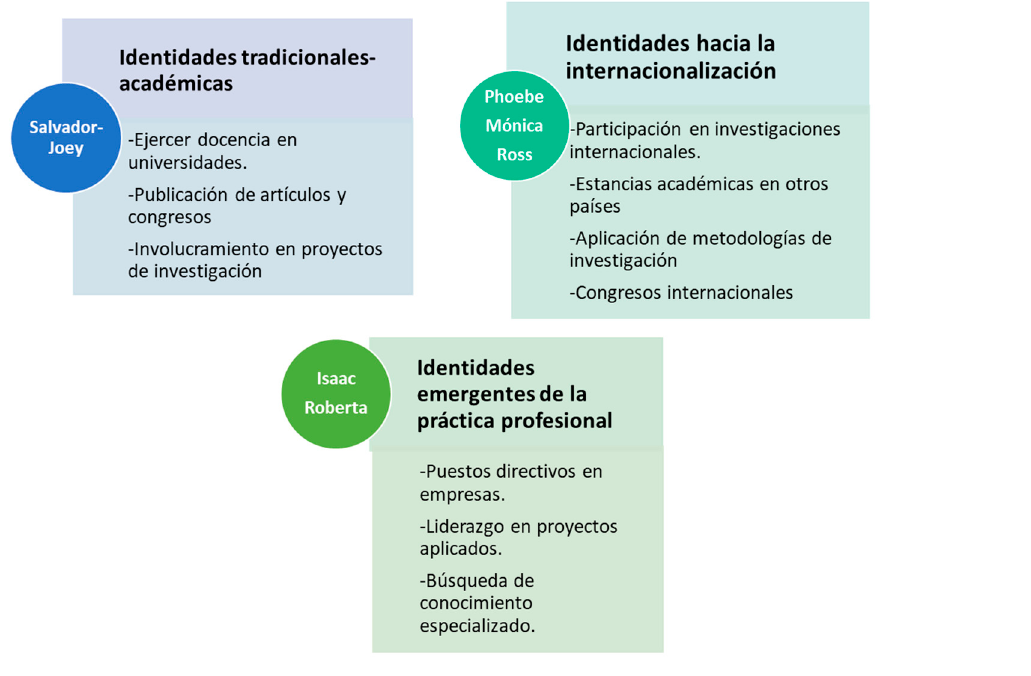
Figure 1. Grouping of the identities displayed by the doctoral